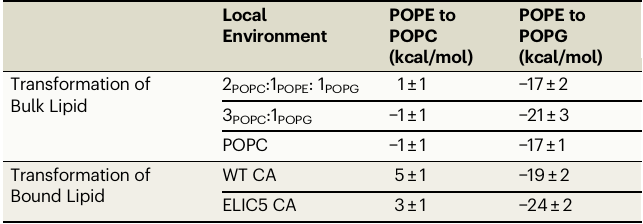
Table 1 | Free energy differences calculated from SAFEP